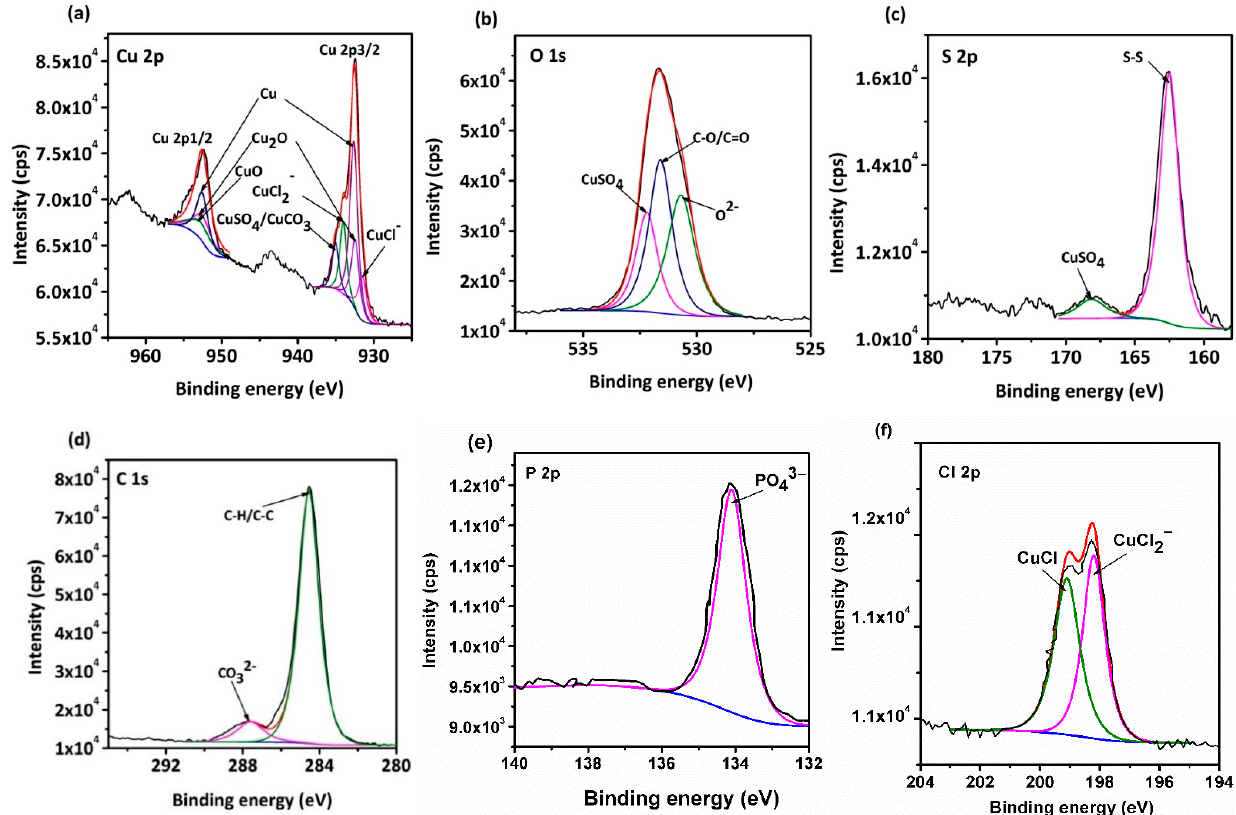
Figure 8. XPS spectra of the corrosion pits of the Cu strip after the electrochemical experiment: ( a ) Cu 2p, ( b ) O 1s, ( c ) S 2p, ( d ) C 1s, ( e ) P 2p, and ( f ) Cl 1s.